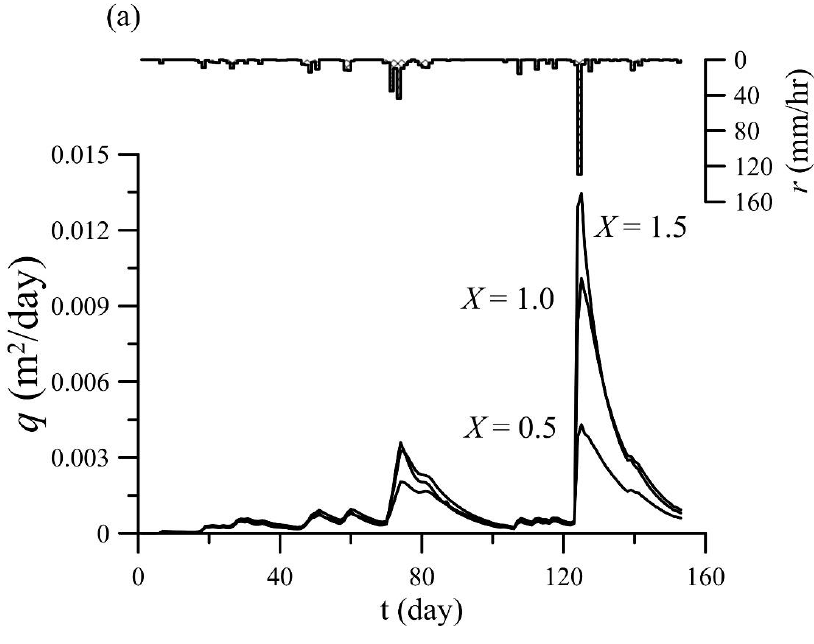
The variation of the flow discharge at different locations, X = 0.5, 1, and 1.5, under given rainfall flow discharge occurred because of the accumulation effect. It also can be seen from Figure 10 that in the case of low recharge rates, the difference in flow rate at different locations of the aquifer is not significant.